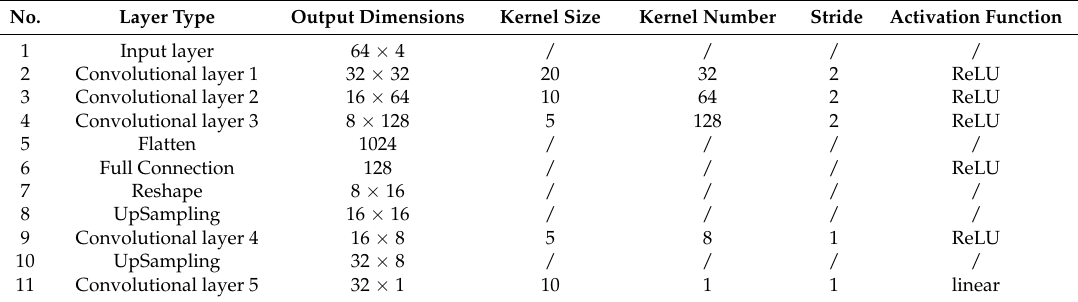
Table 2. Forecasting model